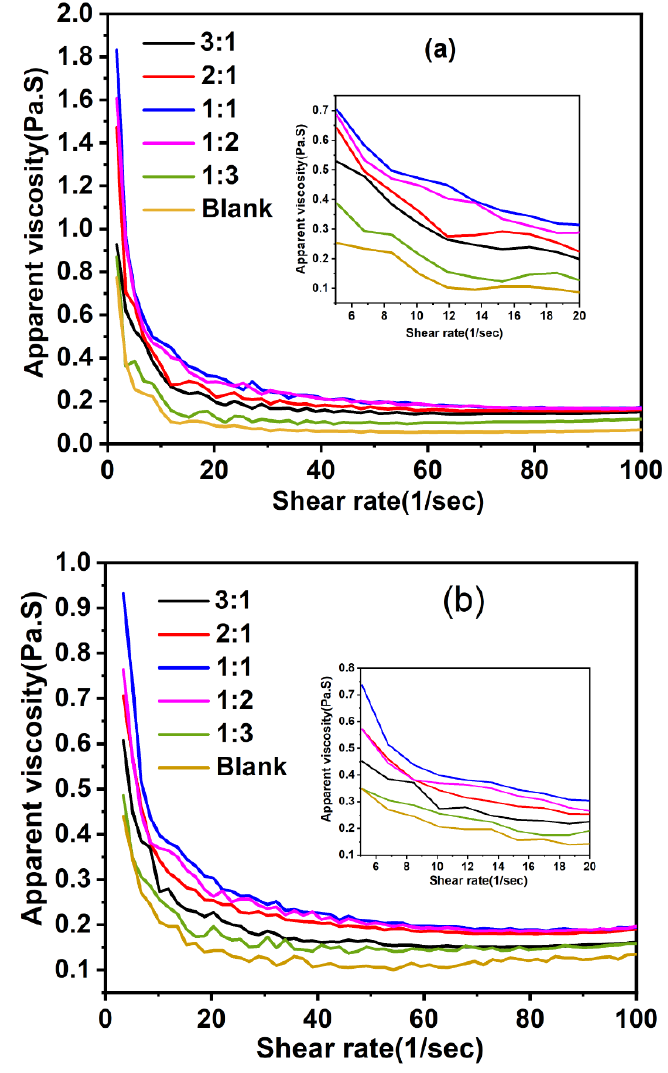
Figure 3. Variation in apparent viscosity with different charge densities of AMPS–DMAA copolymer: ( a ) 5 min, ( b ) 90 min.